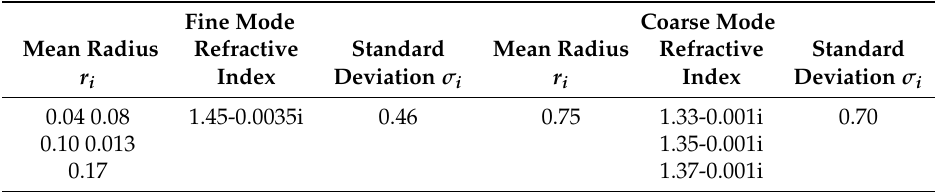
Table 1. Microphysical properties of the fine and the coarse modes of the spherical aerosol models used in this study by POLAC algorithm for the processing of PARASOL time-series data. The mean radius r i , and the standard deviation σ i are given in µ m. The microphysical properties of the non-spherical model are not indicated in the table since its optical properties were directly obtained from laboratory measurements by Volten et al. [63]. Fine Mode Coarse Mode Mean Radius Refractive Standard Mean Radius Refractive